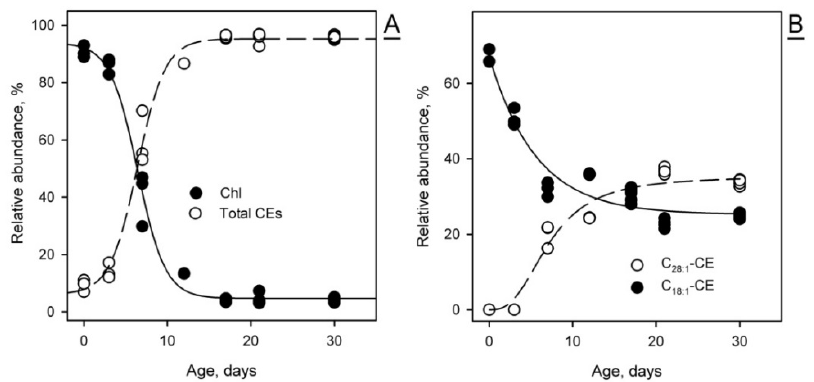
Figure 6. The dynamic changes in free cholesterol (Chl) and cholesteryl esters (CEs) in maturing Meibomian glands of mice. ( A ) The relative abundance of Chl is inversely proportional to the total CE content, and decreases with age. ( B ) The Meibomian CE profile changes with MG maturation: the abundance of shorter chain CEs decreases, while the abundance of extremely long-chain CEs increases. Two specific CEs are shown as examples. Note a lag in the increase in C 28:1 -CE from P0 to P3.